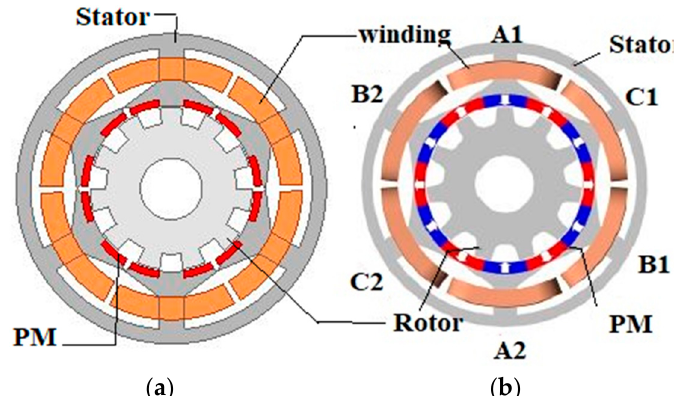
Figure 10. Typical topologies of FRM: ( a ) consequent-pole permanent magnet (CPM)-FRM); ( b ) stator- Figure 10. mounted permanent magnet (SMPM)-FRM [27,28].